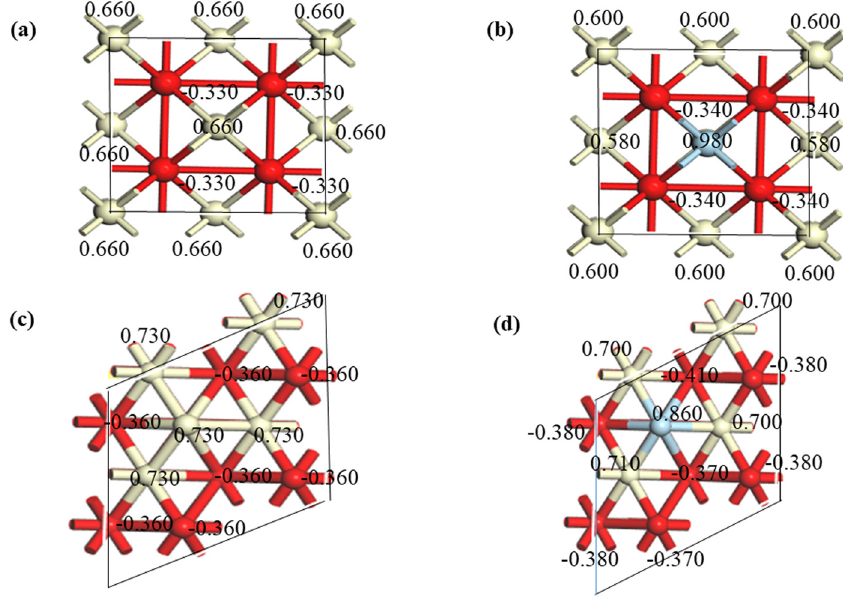
Figure 8: Atomic Hirshfeld charges ( in e ) of ( a ) un - doped bulk, ( b ) doped bulk, ( c ) un - doped surface, ( d ) and doped surface of CeO 2 ( 111 ) .